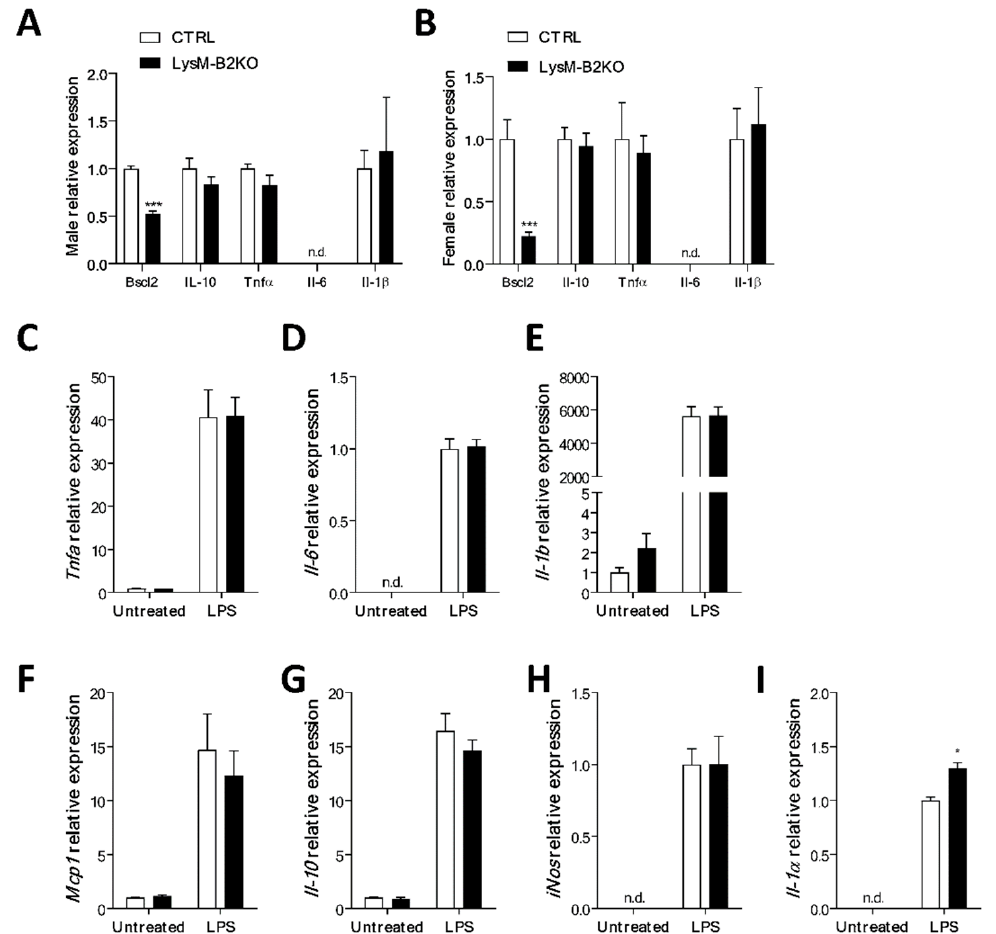
Figure 2. Lipopolysaccharides-mediated inflammatory responses in bone-marrow-derived macrophages. Basal mRNA levels of cytokines in BMDM isolated from ( A ) male and ( B ) female LysM-B2KO mice (female n = 6–7, male n = 6–9). ( C – I ) The treatment of female BMDM with LPS ( n = 6) showed no significant difference in the expression of a panel of cytokines. Gene expression is normalized to three reference genes ( NoNo , Ywhaz and Hprt ). Data are represented as mean ± SEM, * p < 0.05, *** p < 0.001, n.d., not detectable. Next, we examined the intracellular fate and the ability of SKO macrophages to phagocytose a common bacterial pathogen. Control and SKO BMDM were infected with Staphylococcus aureus SH1000 expressing mCherry. After 1.5 h post-infection, bacteria were internalized into macrophages and found in lysosome-associated membrane protein-1 (LAMP-1) positive vacuoles (Figure 3J). Sixty to seventy percent of intracellular S. aureus were found to colocalize with LAMP-1 vacuoles in both control and SKO macrophages